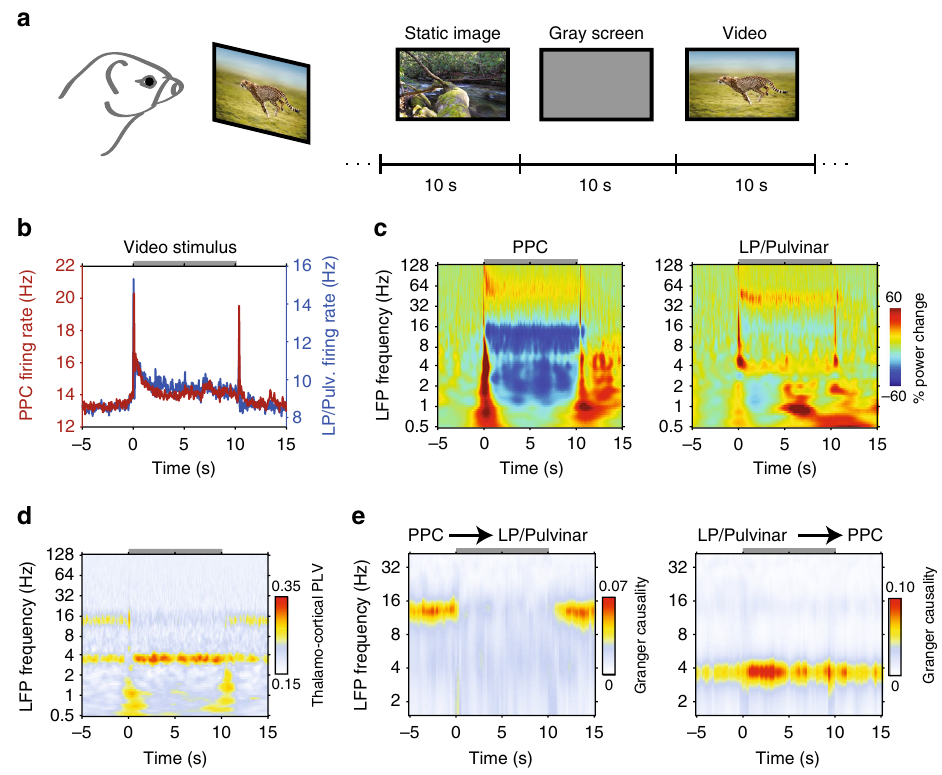
Fig. 5 Visual processing induced changes in thalamo-cortical network dynamics. a Animals passively viewed a collection of naturalistic images or videos. During the interstimulus interval a gray screen was presented. The image “ Running Cheetah ” by Freder is licensed under the Standard iStock Photo License (Getty Images). b Population mean spike rate in PPC and LP/Pulvinar during presentation of video stimuli. The gray bar at the top of the plot indicates the duration of stimulation. c Population LFP spectrograms from PPC (left) and LP/Pulvinar (right) during presentation of naturalistic videos. LFP power was normalized to the period − 5 to − 1 s before stimulus onset. Note the decrease in alpha oscillatory power in PPC during stimulus presentation. d Across- session average thalamo-cortical phase synchronization in response to naturalistic video stimuli. PLV in the theta band is elevated during stimulus presentation, while alpha PLV is weaker. e Time and frequency resolved Granger causality analysis computed between PPC and LP/Pulvinar LFP signals for naturalistic video stimuli. The onset of video stimuli leads to a breakdown of PPC causal in fl uence on LP/Pulvinar in the alpha band (left plot), and an increase of LP/Pulvinar causal in fl uence on PPC in the theta frequency band (right